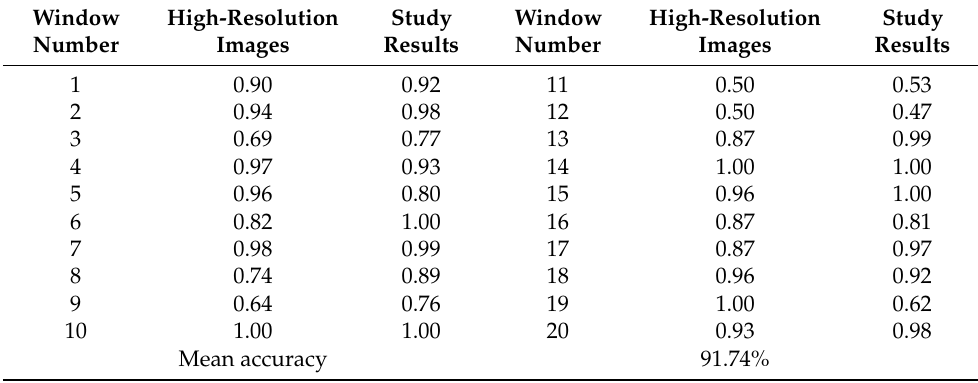
Table A6. Verification results of FVC in